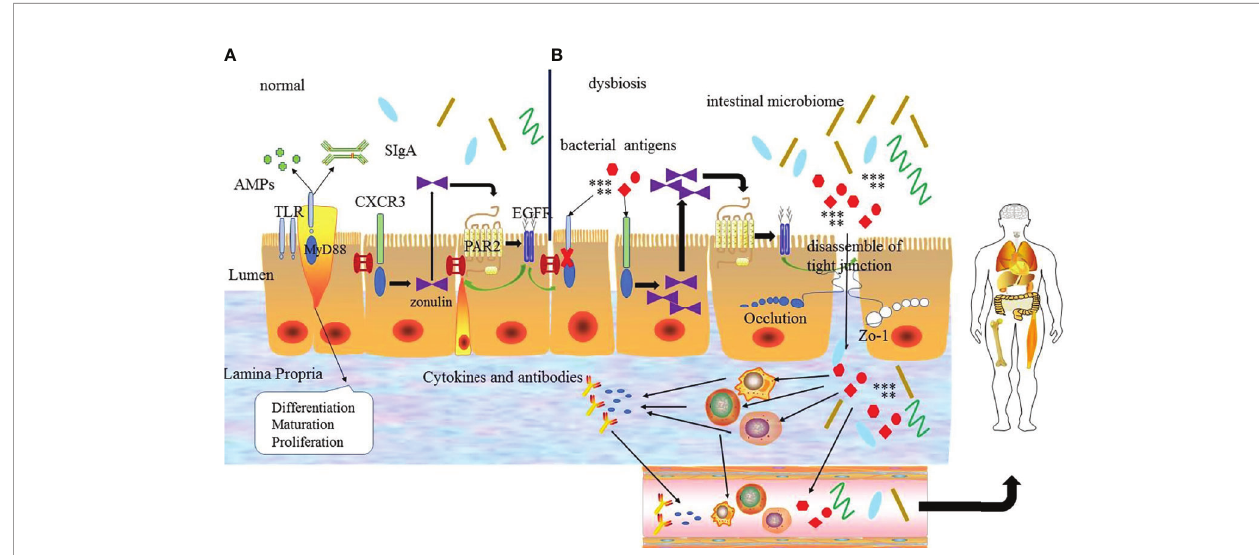
FIGURE 2 | (A) The regulation mechanism of the intestinal mucosal barrier. Under normal circumstances the intestinal mucosal barrier depends on the normal zonulin pathway, intestinal microbiome and Toll-like receptors signal pathway. TLRs can regulate the differentiation, proliferation and maturation of intestinal epithelial cells, zonulin reversibly regulates tight junctions via zonulin pathway and the intestinal microbiome regulates the normal microecological environment, which interacts with each other to guarantee the normal intestinal mucosal barrier function. (B) Under abnormal conditions, bacterial antigens and disordered intestinal microbiome make the TLR signaling pathway abnormal, and the latter destroys the intestinal epithelial cells. At the same time, it can also increase the production of zonulin to promote the zonulin pathway and lead to the destruction of tight junctions ultimately. Bacterial antigens and intestinal microbiome enter into the intestinal lamina propria through the intestinal epithelial cells to interact with immune cells leading to the production of in fl ammatory factors and abnormal antibodies, which enter the blood circulation and fi nally enter the body tissues to promote the development of diseases. EGFR: epidermal growth factor receptor; PAR2: protease-activated receptor